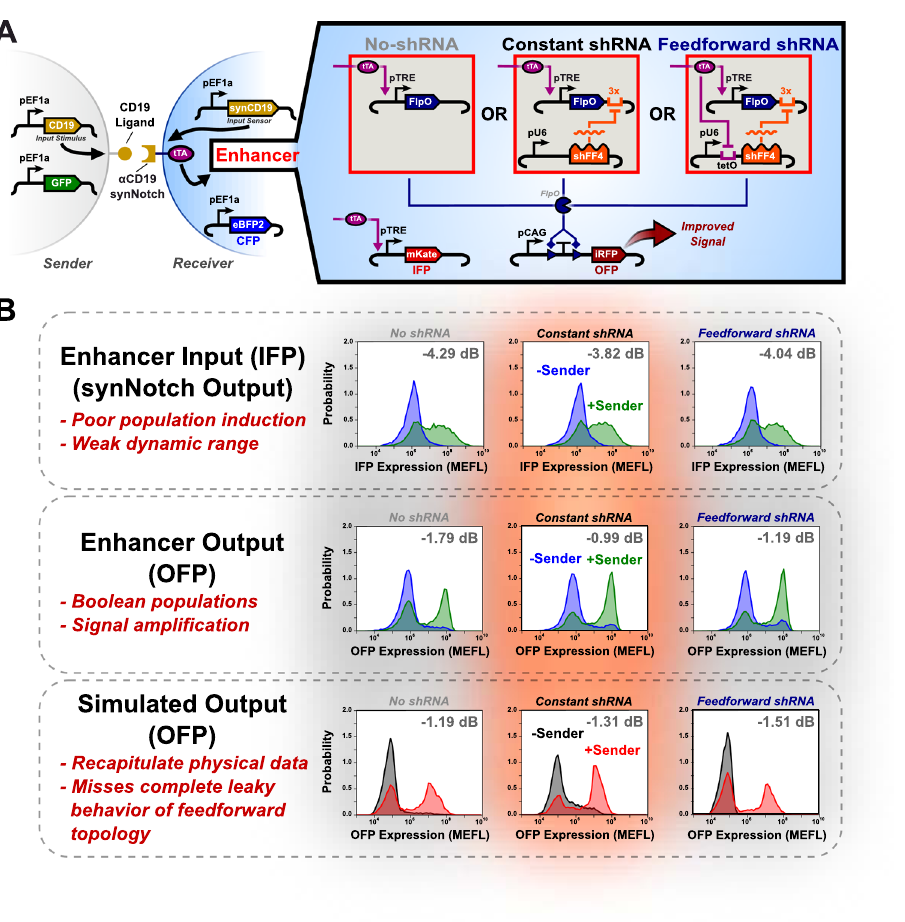
Fig. 4 Model predicts qualitative enhancement of synNotch signaling by digitizer modules. A Diagram of the synNotch sensor coupled with each recombinase digitizer topology. B IFP (top, synNotch output), experimental OFP (middle, digitizer output), and simulated OFP (bottom) signals demonstrate improved population distinguishability after the signal is transduced by the digitizer. Model results for each digitizer ’ s ability to handle the given input signal from the synNotch sensor qualitatively matches each trend. Experimental data (Digitizer Input and Digitizer Output) represent the top 30% of cells expressing a CFP at 48 h post coculture (72 h post